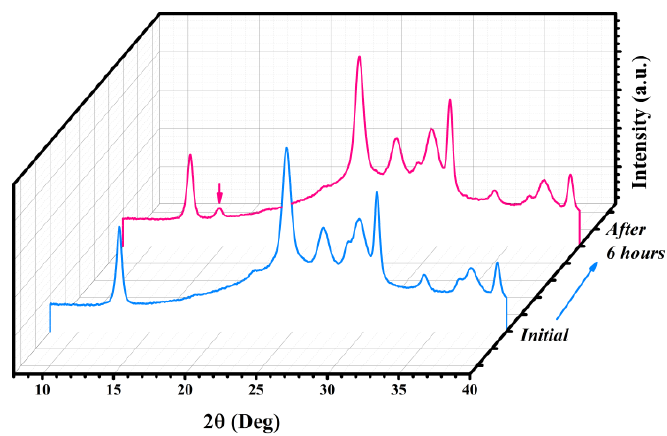
Figure 7. XRD results of PyPbI 3 initial and after 6 h with T = 85 ◦ C.